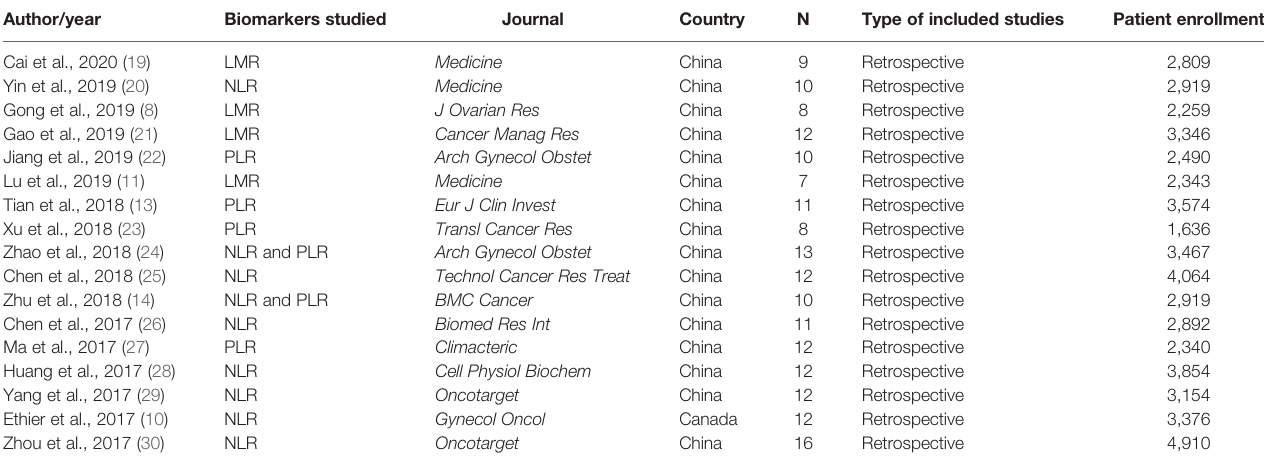
TABLE 1 | General characteristics of included systematic reviews and